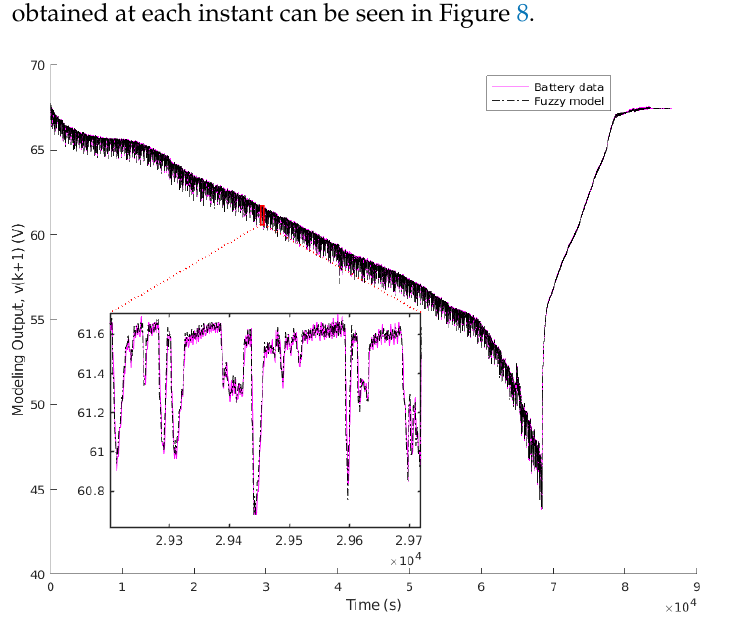
Figure 7. Modeling